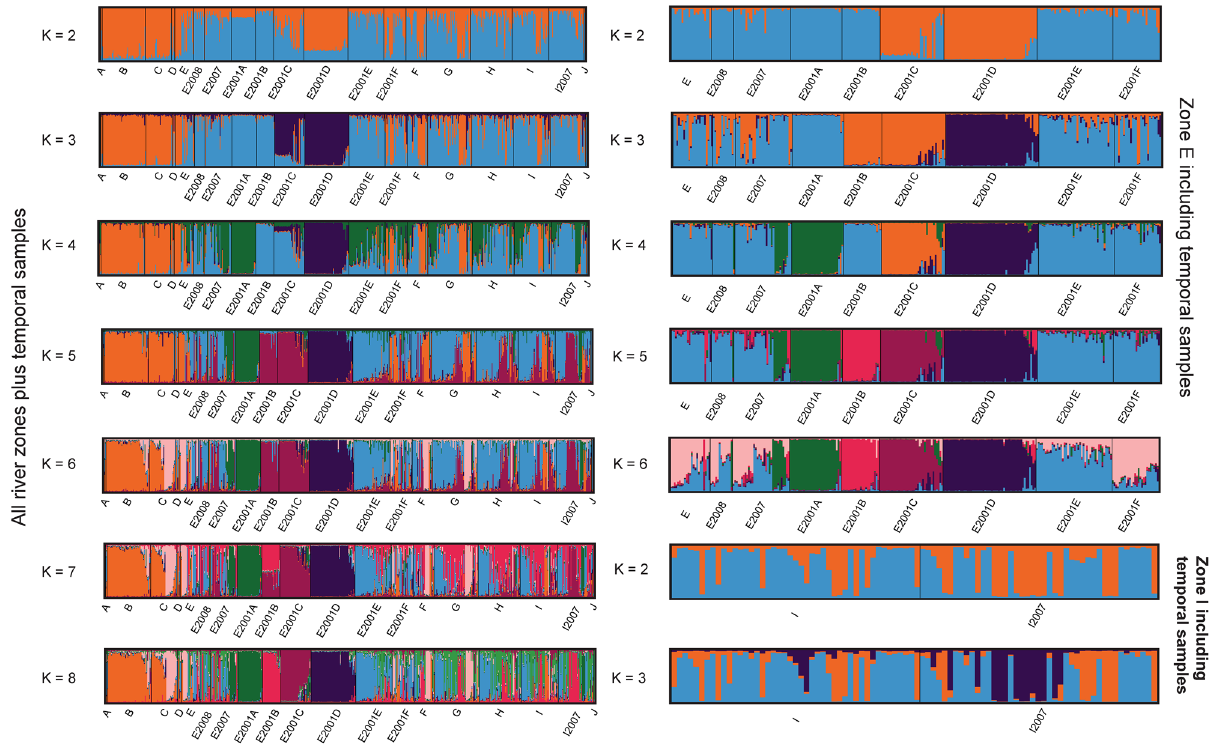
material. On the left-hand side, STRU CTU RE bar plots for all investigated river zones (i.e., A–J) plus temporal groups (i.e., E2008, E2007, E2001A-E2001F, and I2007), are shown. On the right-hand side, additional STRU CTU RE bar plots for zone E and I are displayed that include temporal